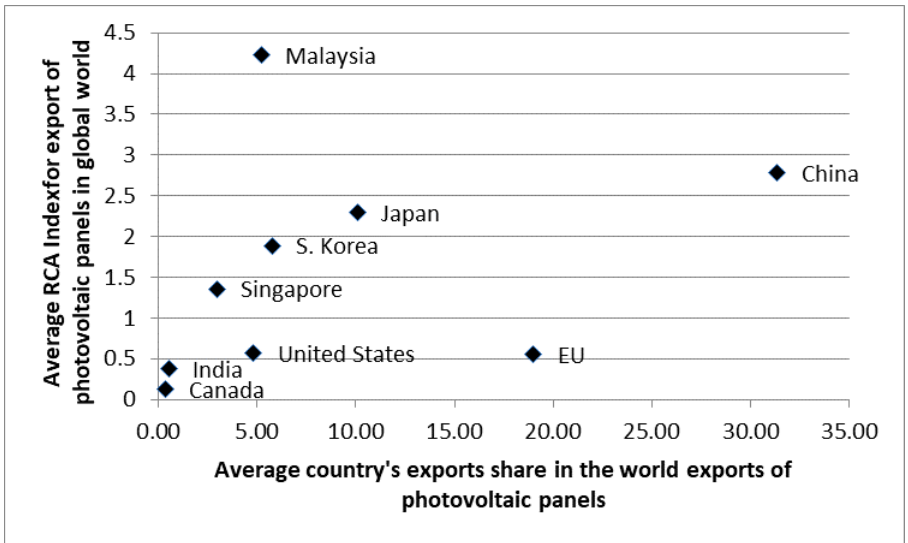
Figure 3. Revealed Comparative Advantage ( RCA ) index versus country’s exports share in the world exports of photovoltaic panels. Source: own elaboration.